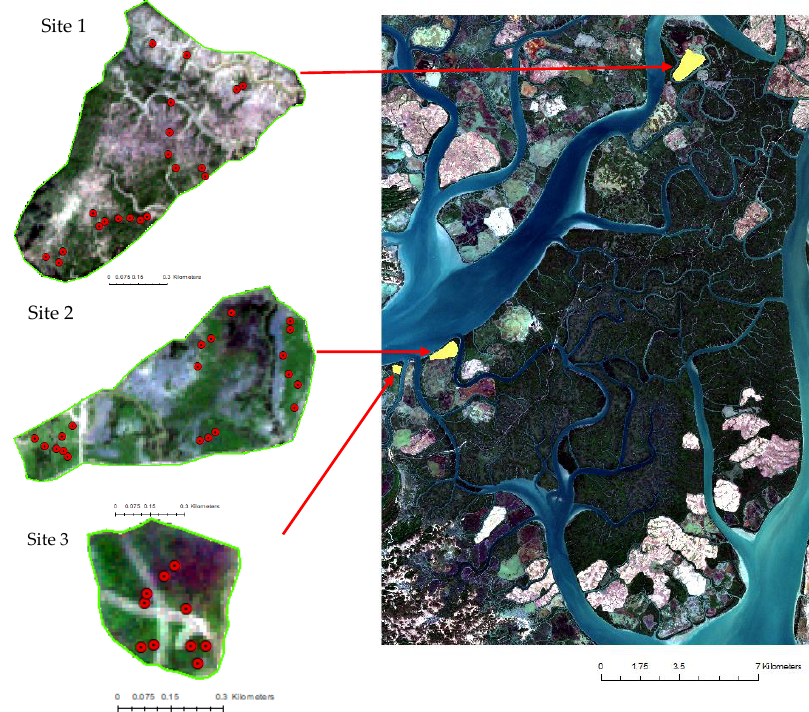
Figure 3. Locations of three selected abandoned sites and sample plots. Table 1. Ground location points of different land uses in the study area.